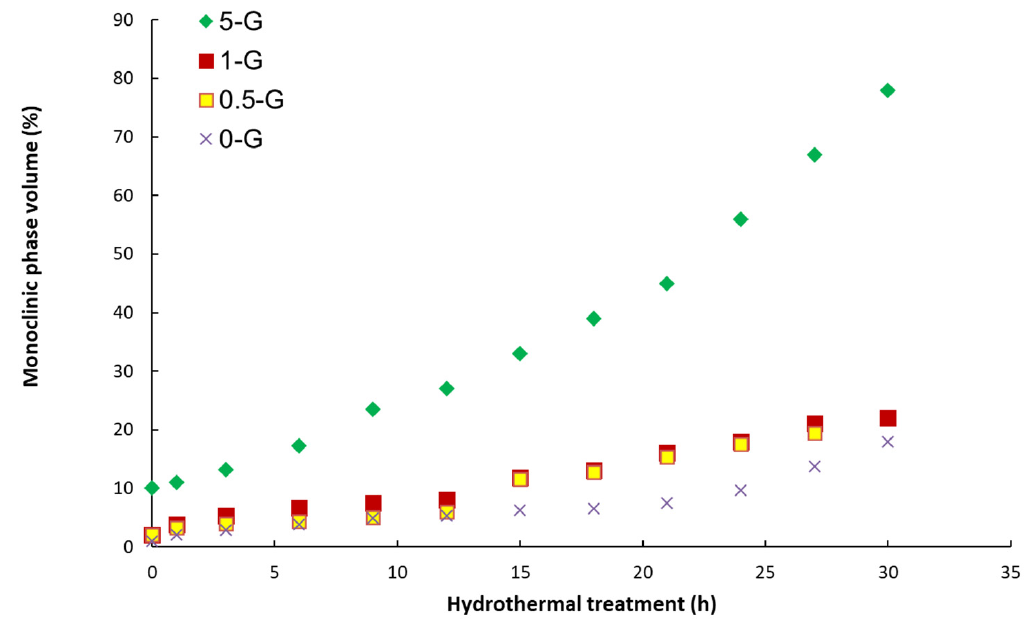
Figure 8. LTD—evolution of the volume fraction of monoclinic transformed ZTA-G in dependence on the aging treatment time.